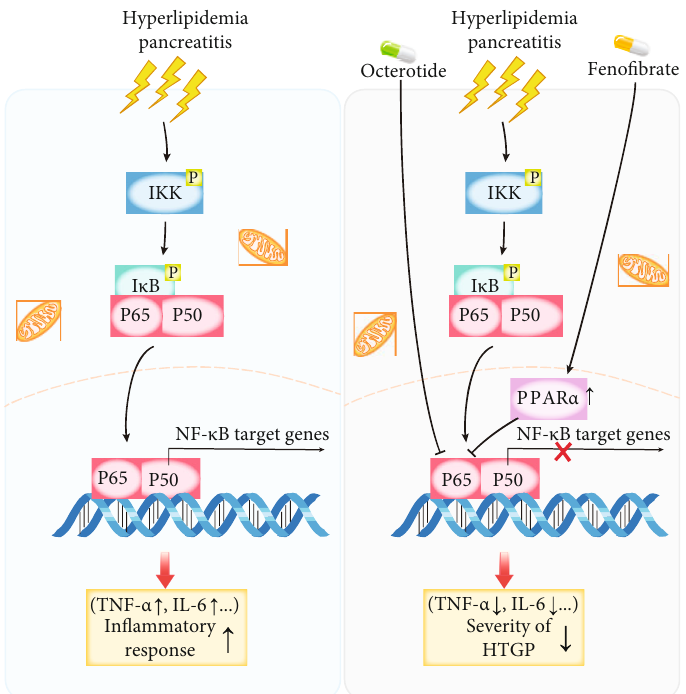
Figure 5: The role of PPARa and octreotide as tightly interacting transcription factors in hyperlipidemia pancreatitis. IKK: I κ B kinase; HTGP: hyperlipidemia